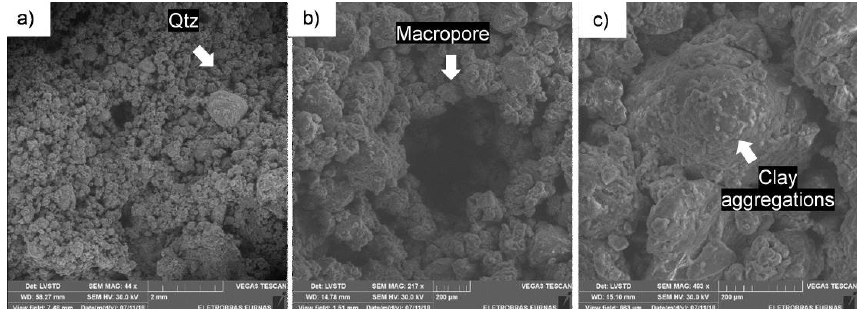
Figure 3. SEM micrographs of the untreated lateritic soil: ( a ) the general aspect of the lateritic soil and a quartz grain (Qtz), shown at a magnification of 44×; ( b ) a macropore created by biological agents, shown at a magnification of 217×; ( c ) aggregation of the clay minerals, shown at a magnification of 493×.